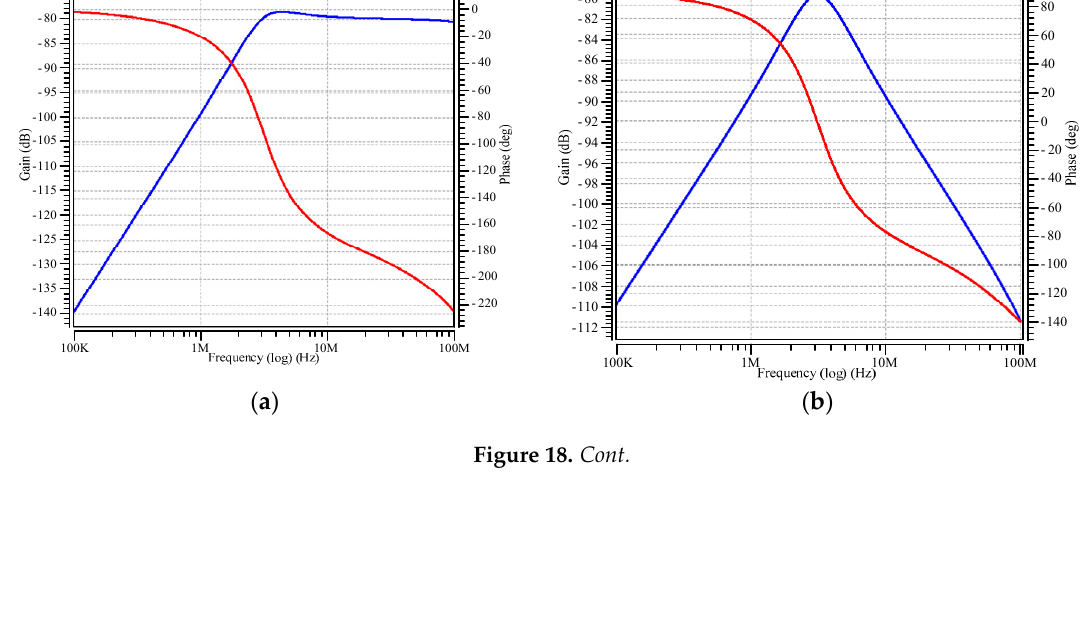
( d ) Figure 18. The TAM post-layout gain (blue line) and phase (red line) simulation responses ( a ) highpass filter (I o1 /V in ); ( b ) bandpass filter (I o2 /V in ); ( c ) lowpass filter (I o3 /V in ); and ( d ) bandstop filter (I o4 /V in ).